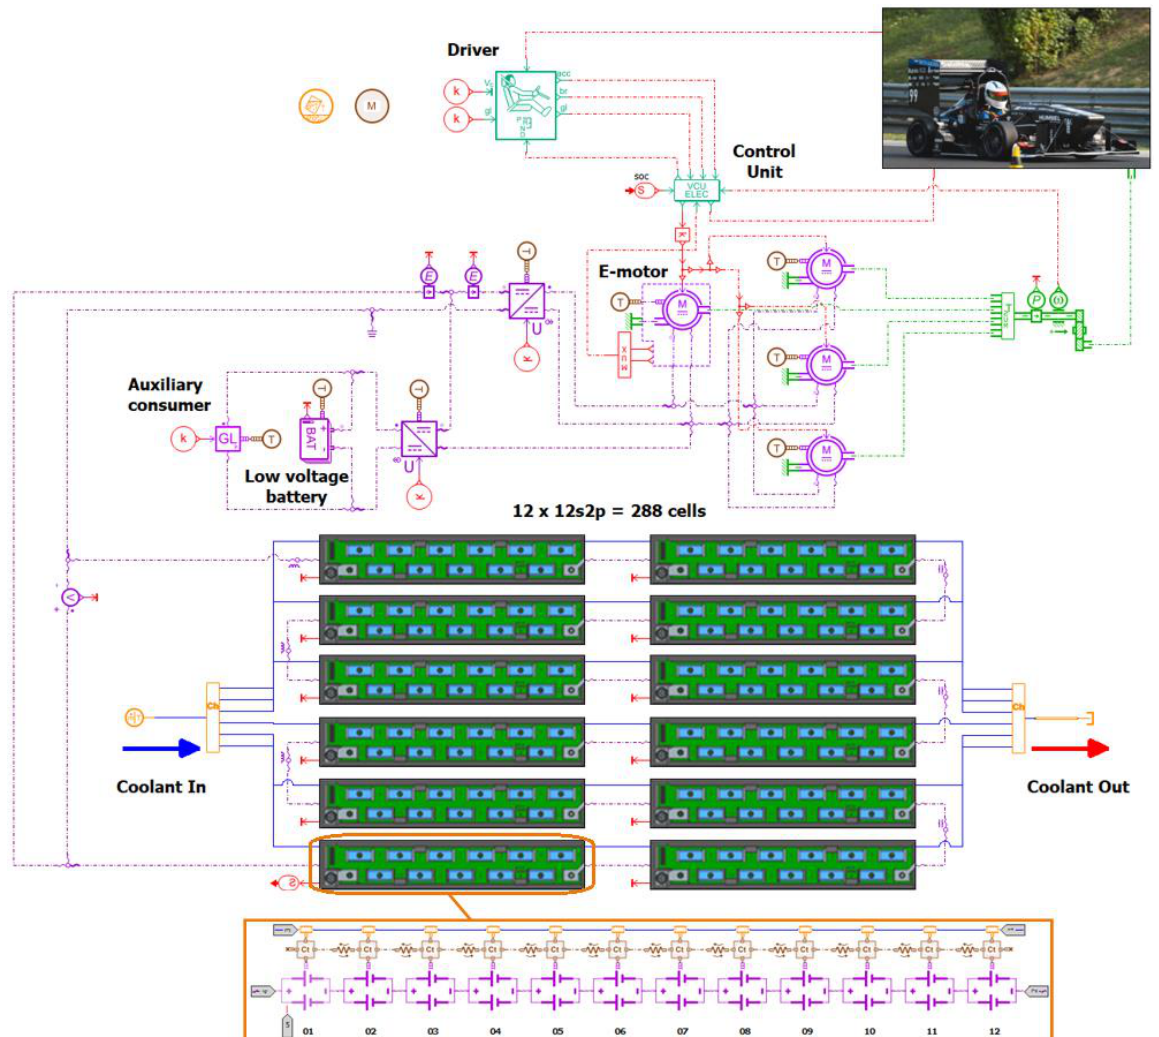
Figure 13. Full vehicle system simulation model in Simcenter Amesim.